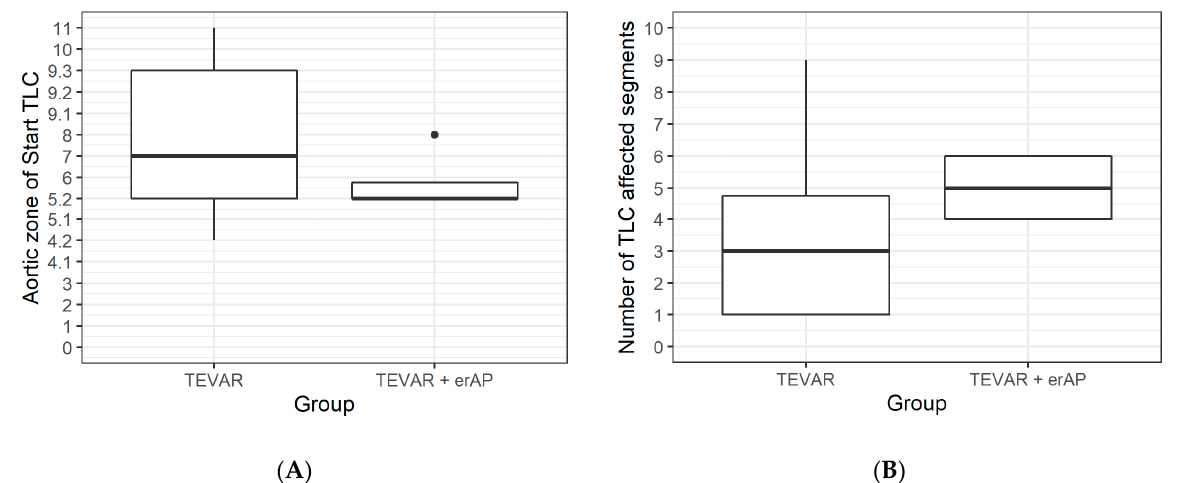
Figure 7. Boxplots representing the starting point ( A ) and the extent of true lumen collapse (TLC) ( B ) in cases treated with TEVAR alone versus TEVAR + erAP